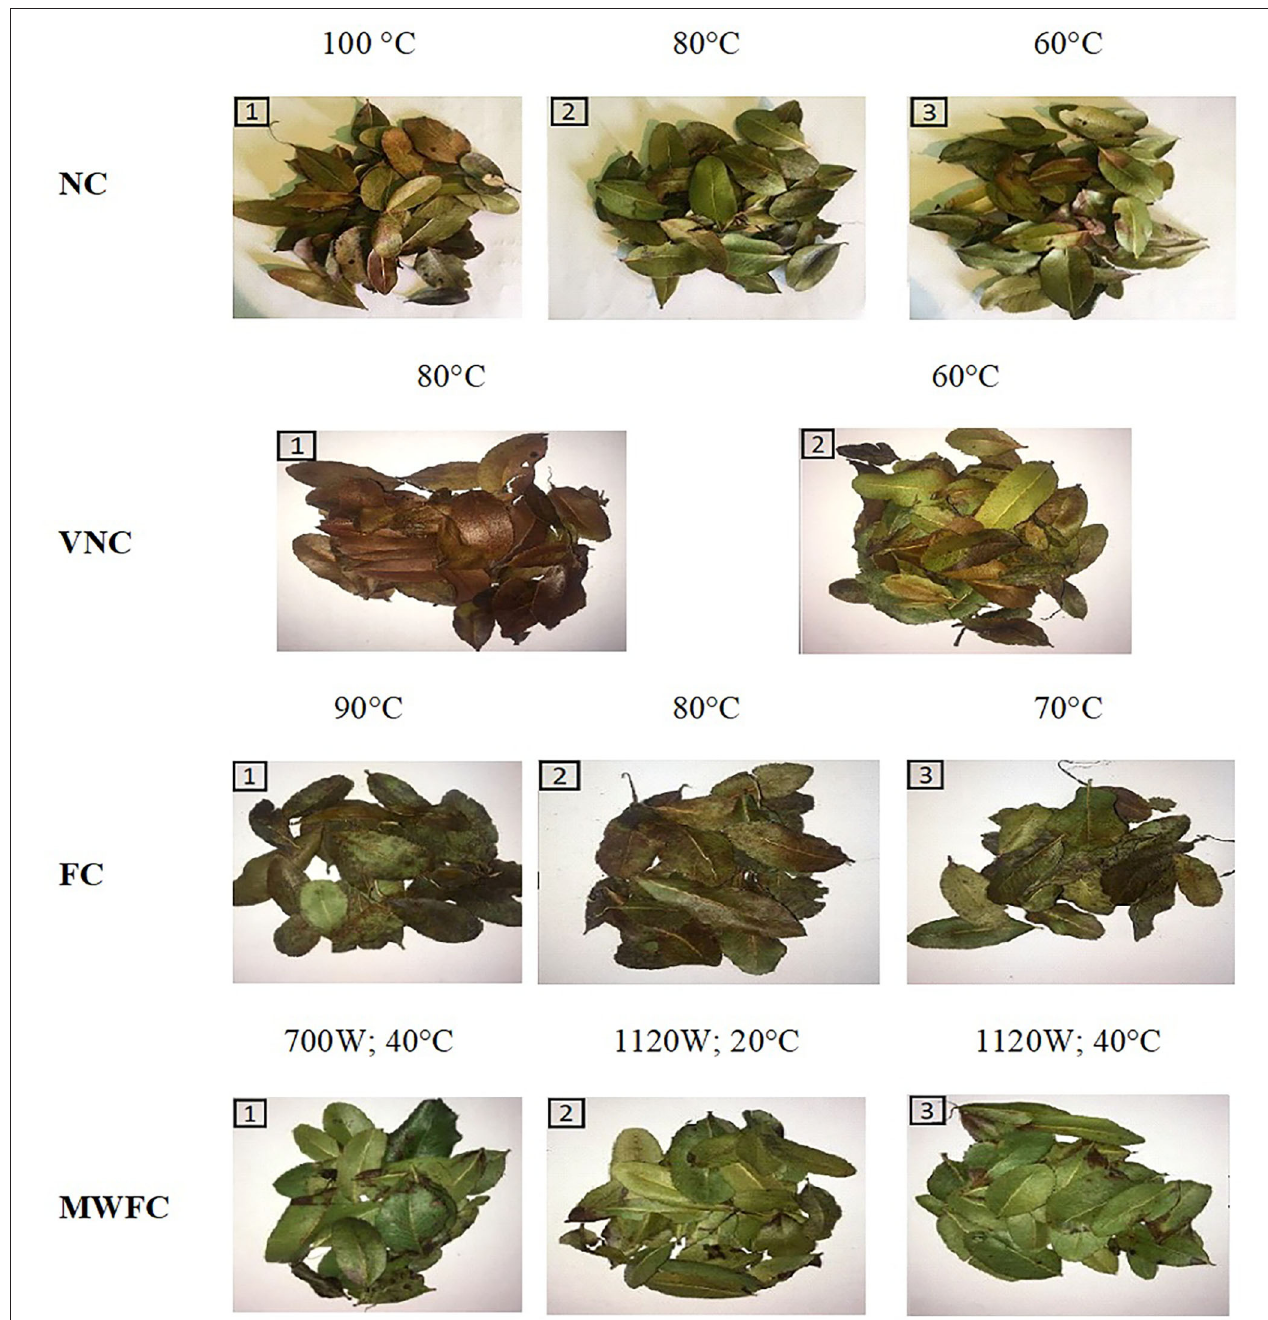
FIGURE 2 | Kageneckia oblonga leaves after applying different drying methods and under different operating conditions.